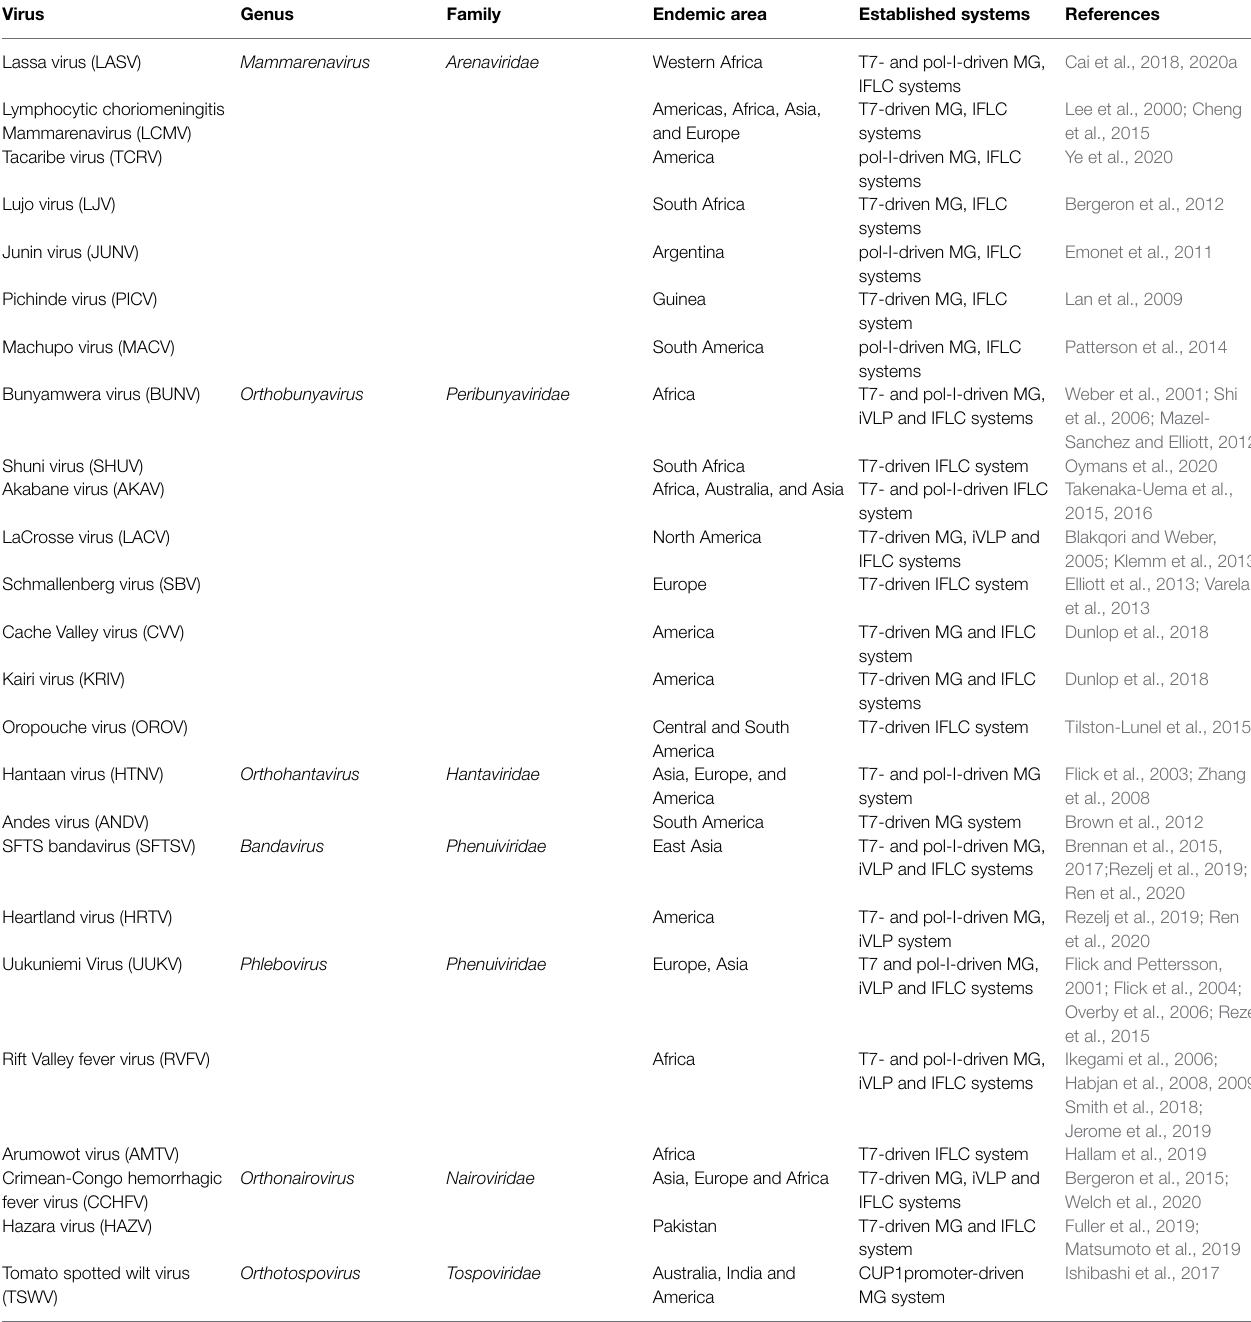
TABLE 1 | Summary of the established reverse genetics systems for Bunyavirales